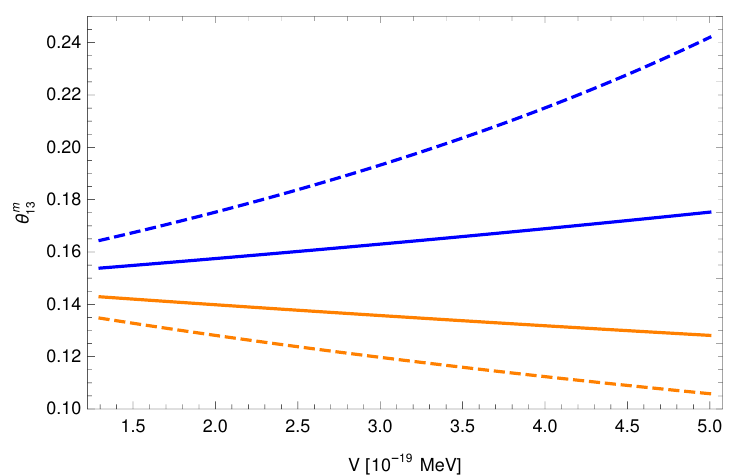
Figure 2 . (cid:18) m in matter as the function of neutrino interaction potential in Earth for normal (blue 13 line) and inverted (orange line) mass ordering and for the neutrino energies E = 400 MeV (solid lines) and E = 1000 MeV (dashed